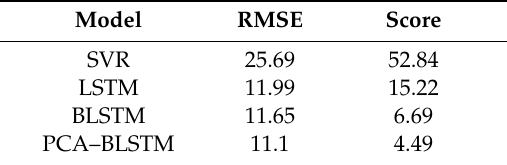
Table 6. Comparison of the experimental